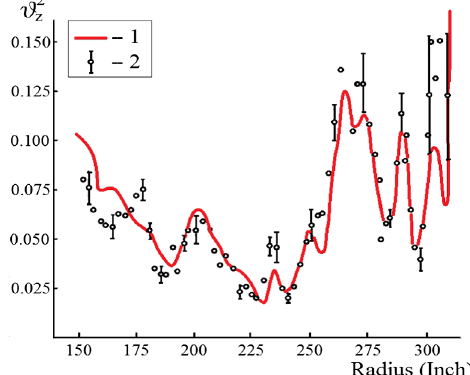
FIG. 1. Square of an axial frequency as a function of radius at TRIUMF cyclotron: 1 — calculation with CYCLOPS (solid line), 2 — measurements (data points)